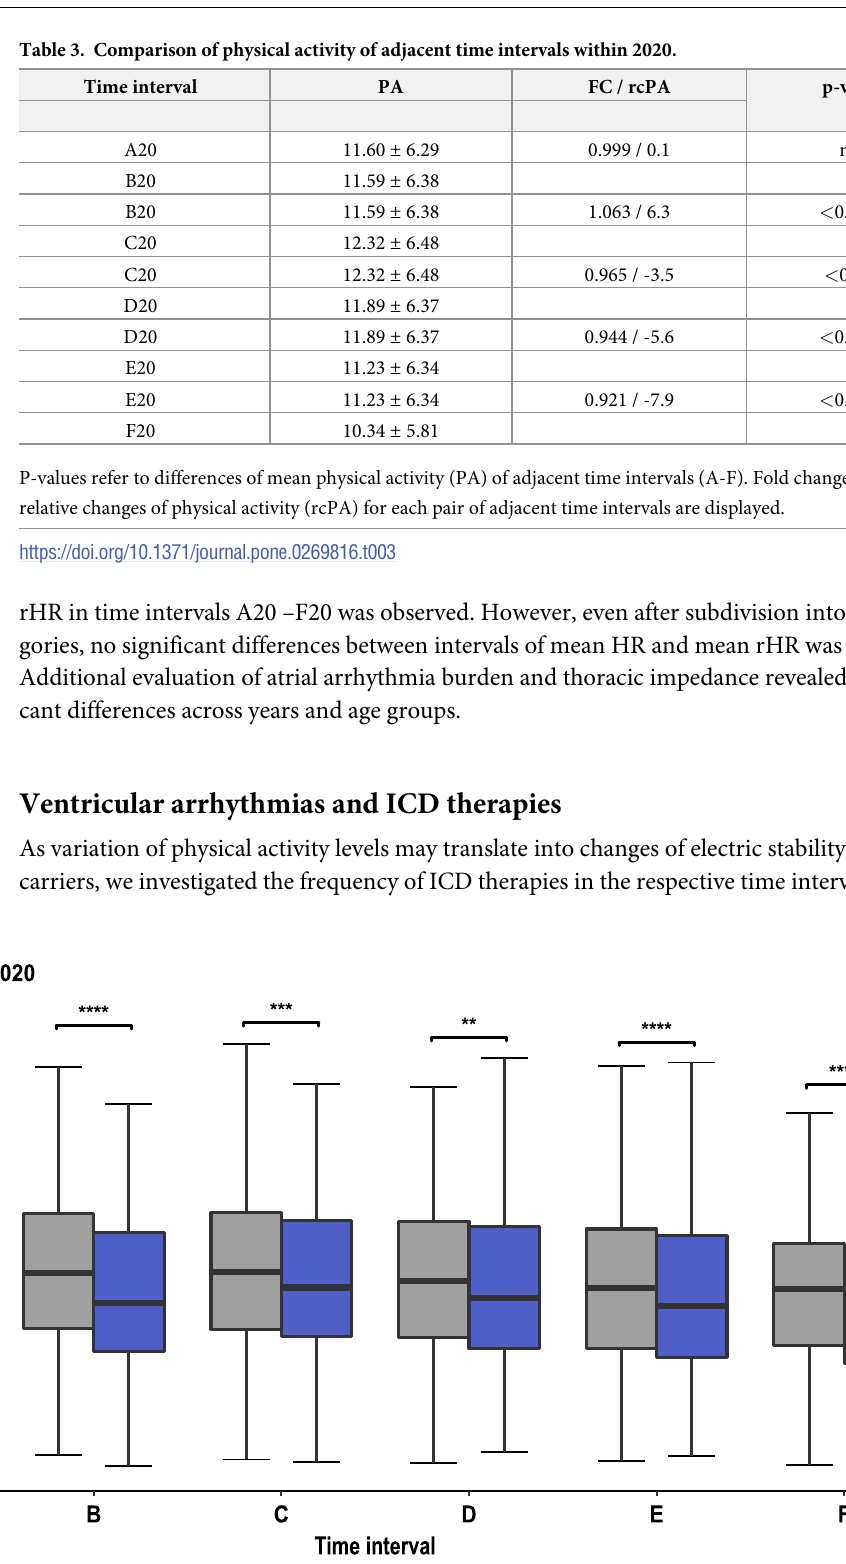
Fig 4. Comparison of physical activity of corresponding time intervals in 2019 and 2020. Box-Whisker-Plot of mean physical activity. Intervals A to F, marking time intervals with different levels of health restrictions in 2020 are annotated and transferred identically to the year 2019. Significant changes in physical activity between corresponding intervals are annotated ( � = p < 0.05, �� = p < 0.01, ��� = p < 0.001, ���� = p < 0.0001).